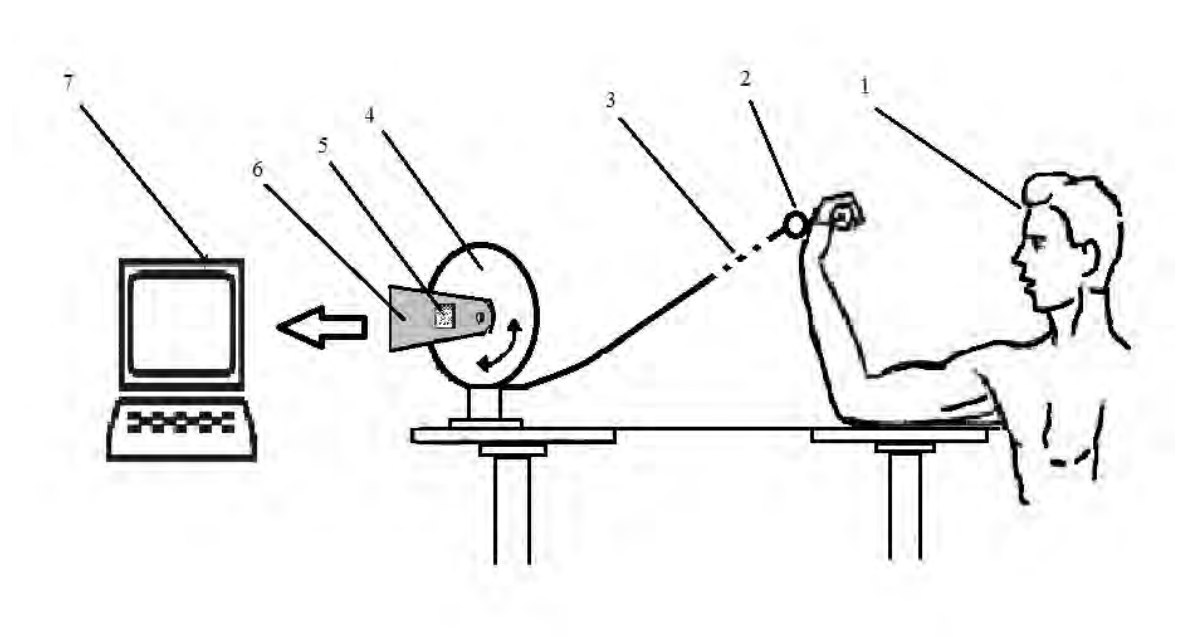
Fig.1. Structural diagram of monitoring of power abilities’ functional state: 1 – subject of monitoring; 2 – sensor; 3 – cord; 4 – drum; 5 – laser sensor of movement; 6 – system of sensor’s fastening; 7 – electronic calculation